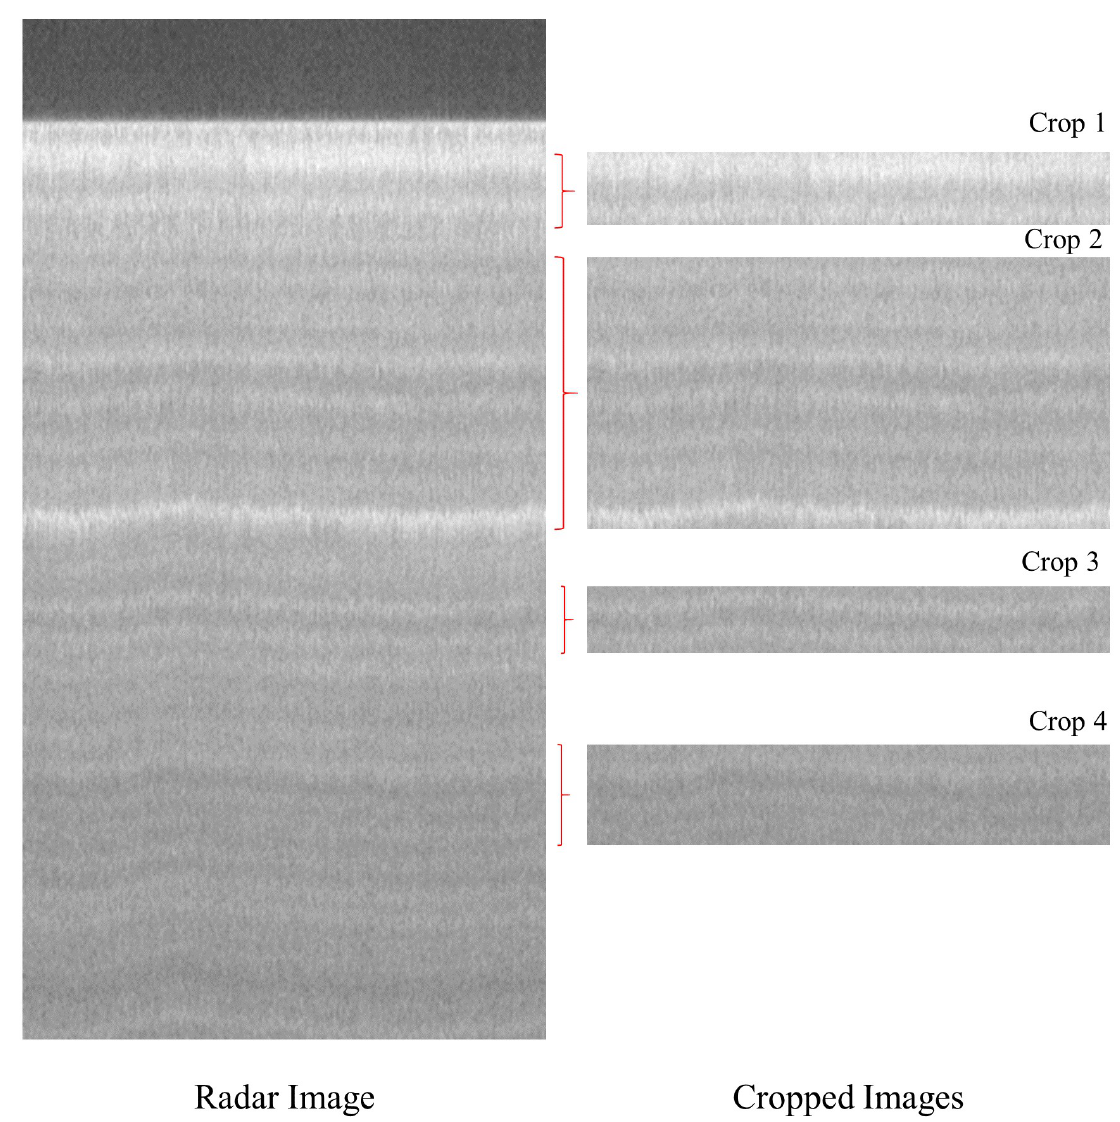
Figure 5. Corresponding radar image of Figure 4, where matching portions have been cropped